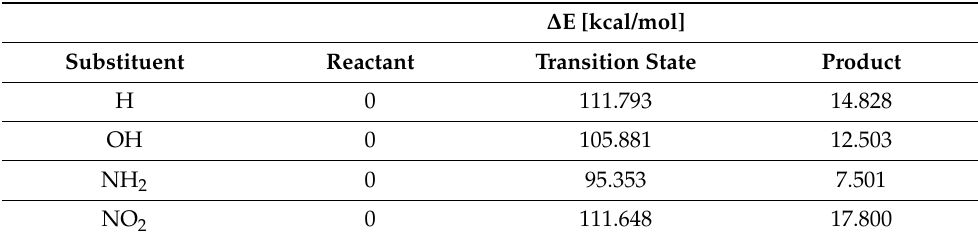
Table 6. Energies at 298 K for optimized structures of the transition state, the reactants, and products for 1,8-dihydroxy-9-anthrone with different